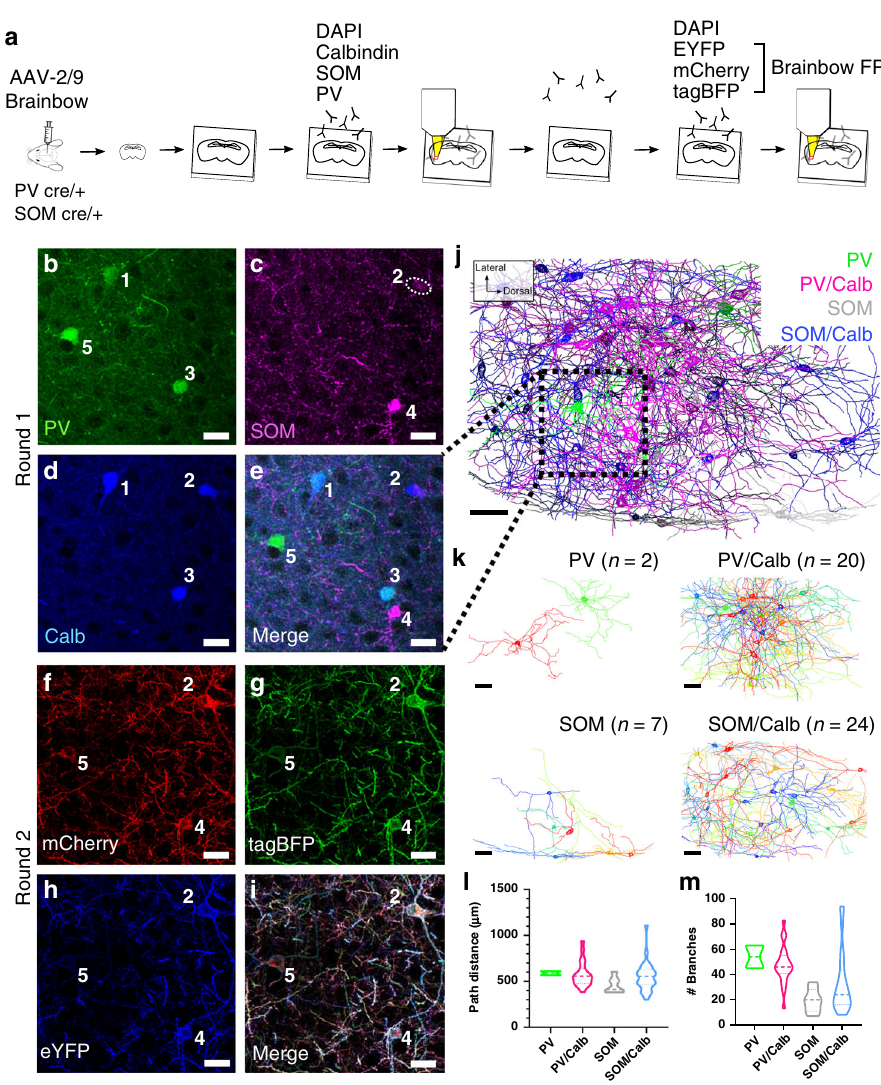
Fig. 2 miriEx combined with Brainbow to simultaneously pro fi le molecular expression and neuron morphologies. a Experiment design: Brainbow and molecular markers were imaged across two rounds of immunostaining using the DAPI channel for registration. b – e MIP showing the molecular markers (PV, SOM, Calb) imaged in round 1. Four distinct molecular subtypes could be identi fi ed: PV, PV/Calb, SOM, SOM/Calb. ( f – i ) MIP showing the Brainbow channels imaged in round 2. j nTracer reconstruction of 53 neurons encompassing the four subtypes previously identi fi ed in a 590 × 404 × 160 μ m 3 volume. The red square represents the fi eld of view seen in ( b – i ). k Individual nTracer reconstructions based on molecular subtype. l Total path distance plotted for each of the molecular subtypes. m Number of dendritic branches plotted for each of the molecular subtypes. Violin-plot: bold dashed line, median; dashed line, upper and lower quartiles. MIP maximum intensity projection, PV parvalbumin, Calb calbindin, SOM somatostatin. Scale bars: ( b – i